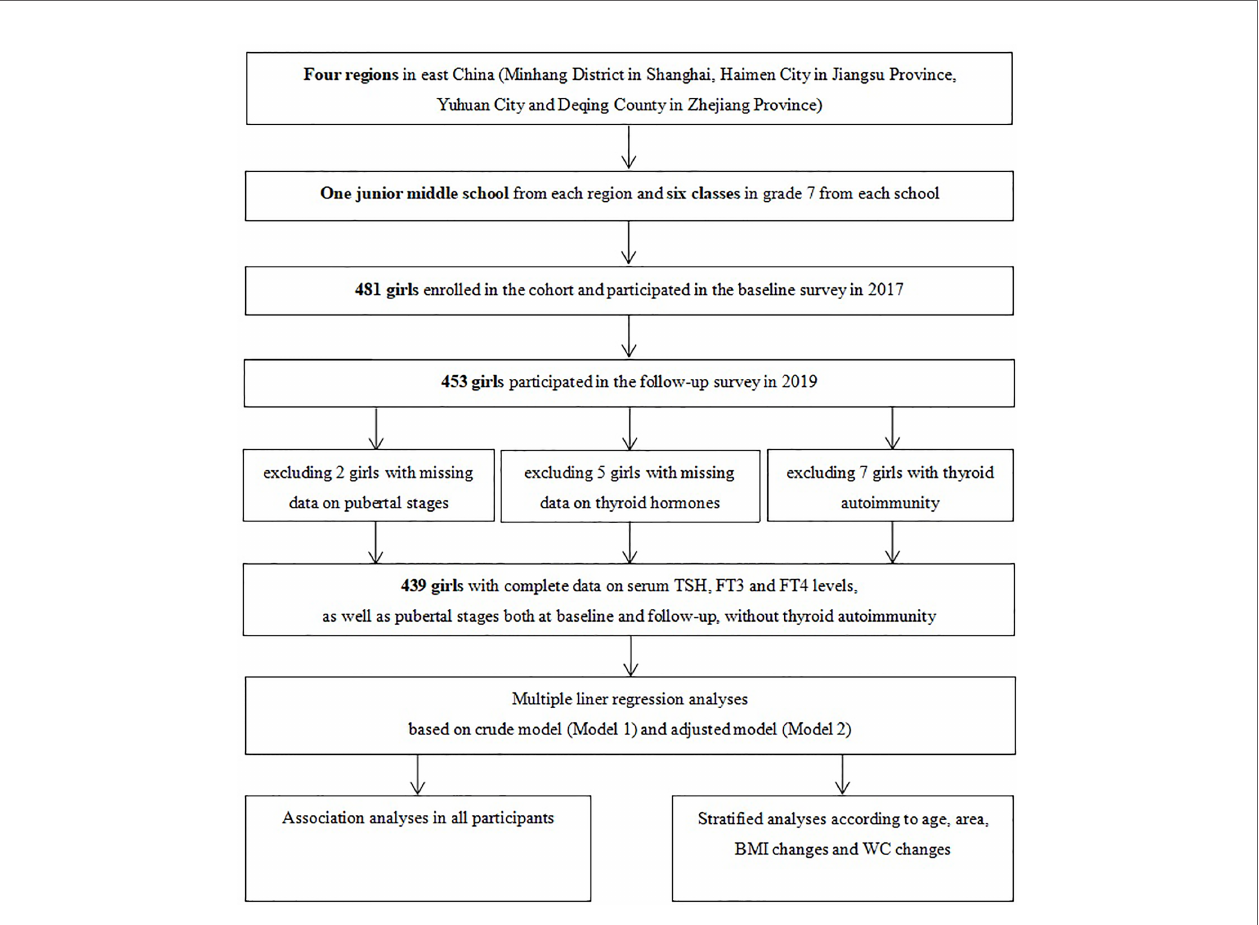
FIGURE 1 | Flow chart for the